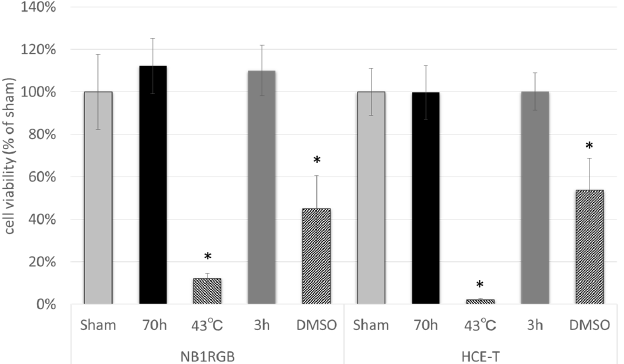
Figure 5. Cells following exposure to 0.3 – 0.6 THz waves for 94 h (x5).